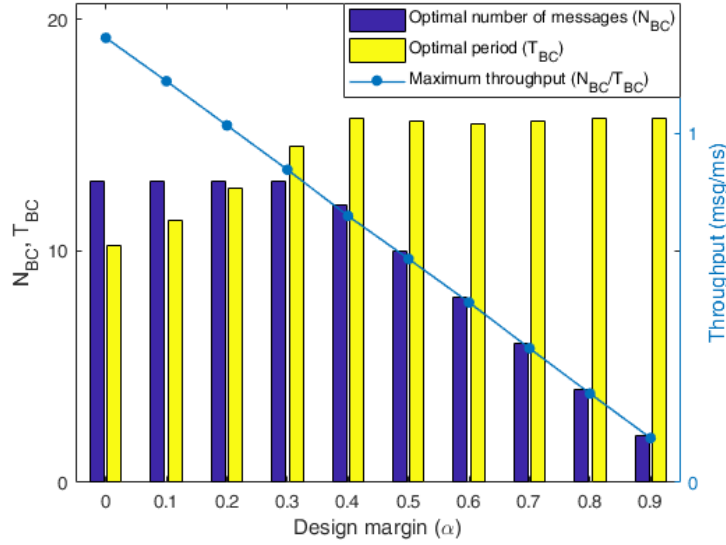
Figure 9. Optimization results according to the design margin ( α ) with 500 samples in the FRMCO.